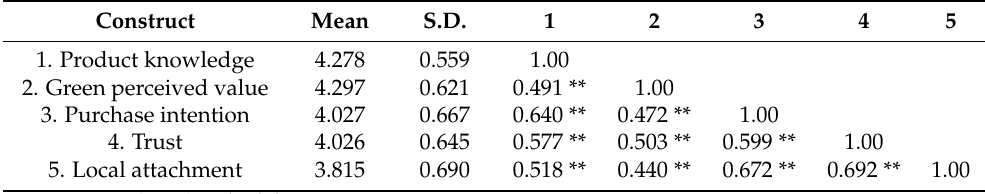
Table 3. Means, standard deviations, and correlations of constructs.